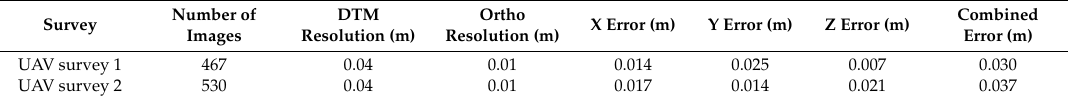
Table 1. Model statistics for small unmanned aerial vehicle surveys of Liza